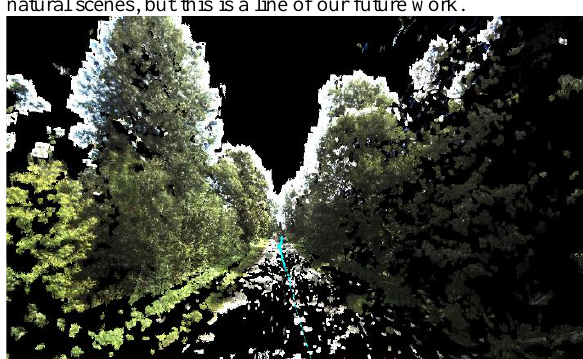
Figure 12. Semi-dense scene